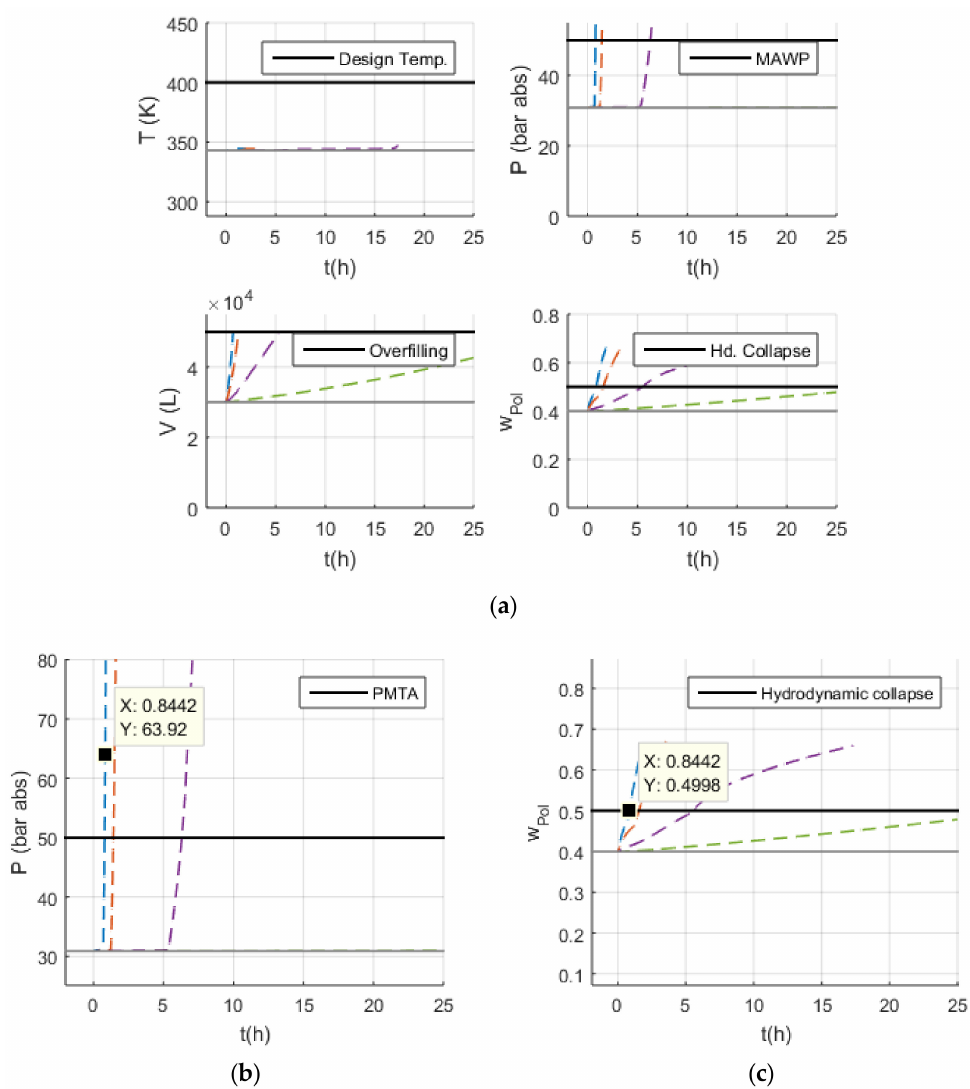
Figure 28. ( a ) Behavior of critical variables in scenarios S-29 and S-30 with Model 3; ( b ) pressure dynamics for interruption of the slurry mass flowrate; ( c ) polymer fraction dynamics for interruption of slurry mass flowrate. Slurry mass rate: ( ) no flow; ( ) 50% of normal flow; ( ) 90% of normal flow; ( ) 99% of normal flow; ( )